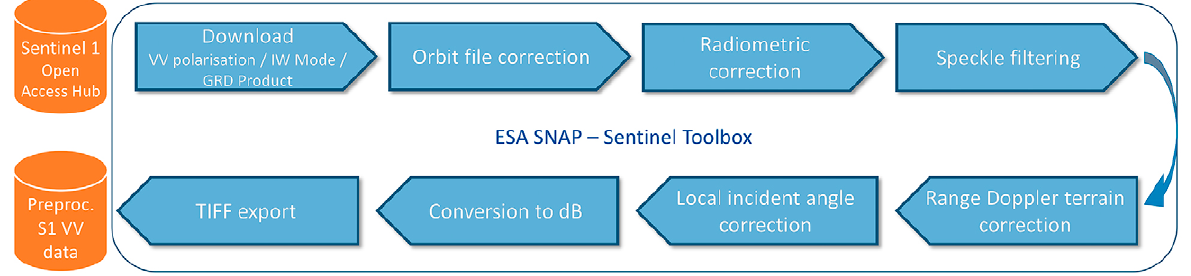
Figure 2. Raw data processing in ESA SNAP